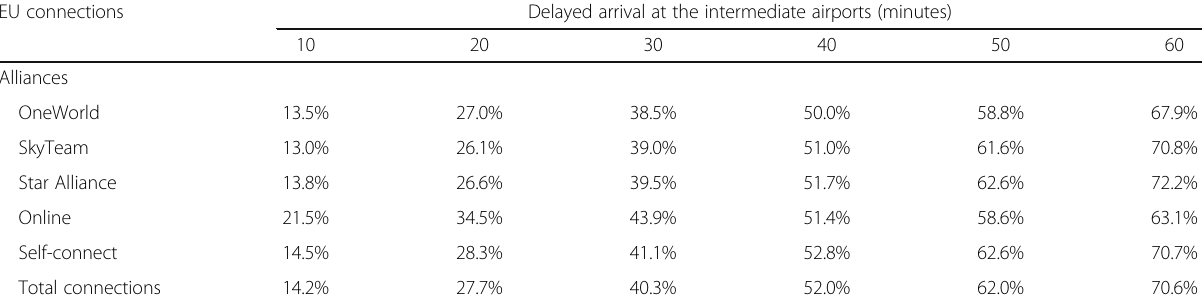
Table 6 Percentage of missed connections to EU destinations related to delayed arrivals at intermediate airports EU